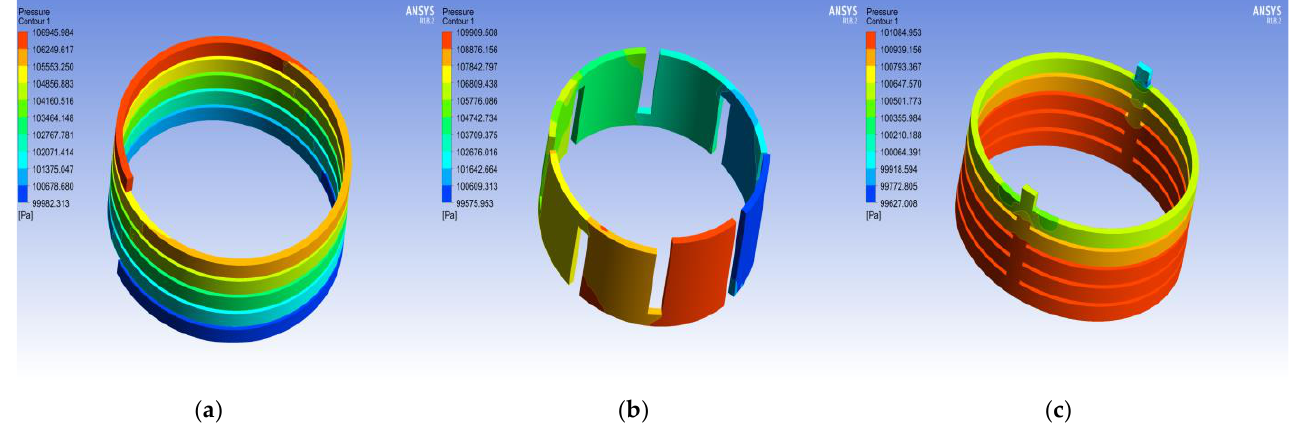
Figure 10. Pressure distribution with different types of housing cooling structures. ( a ) Spiral channel. ( b ) Axial channel. ( c ) Parallel channel.